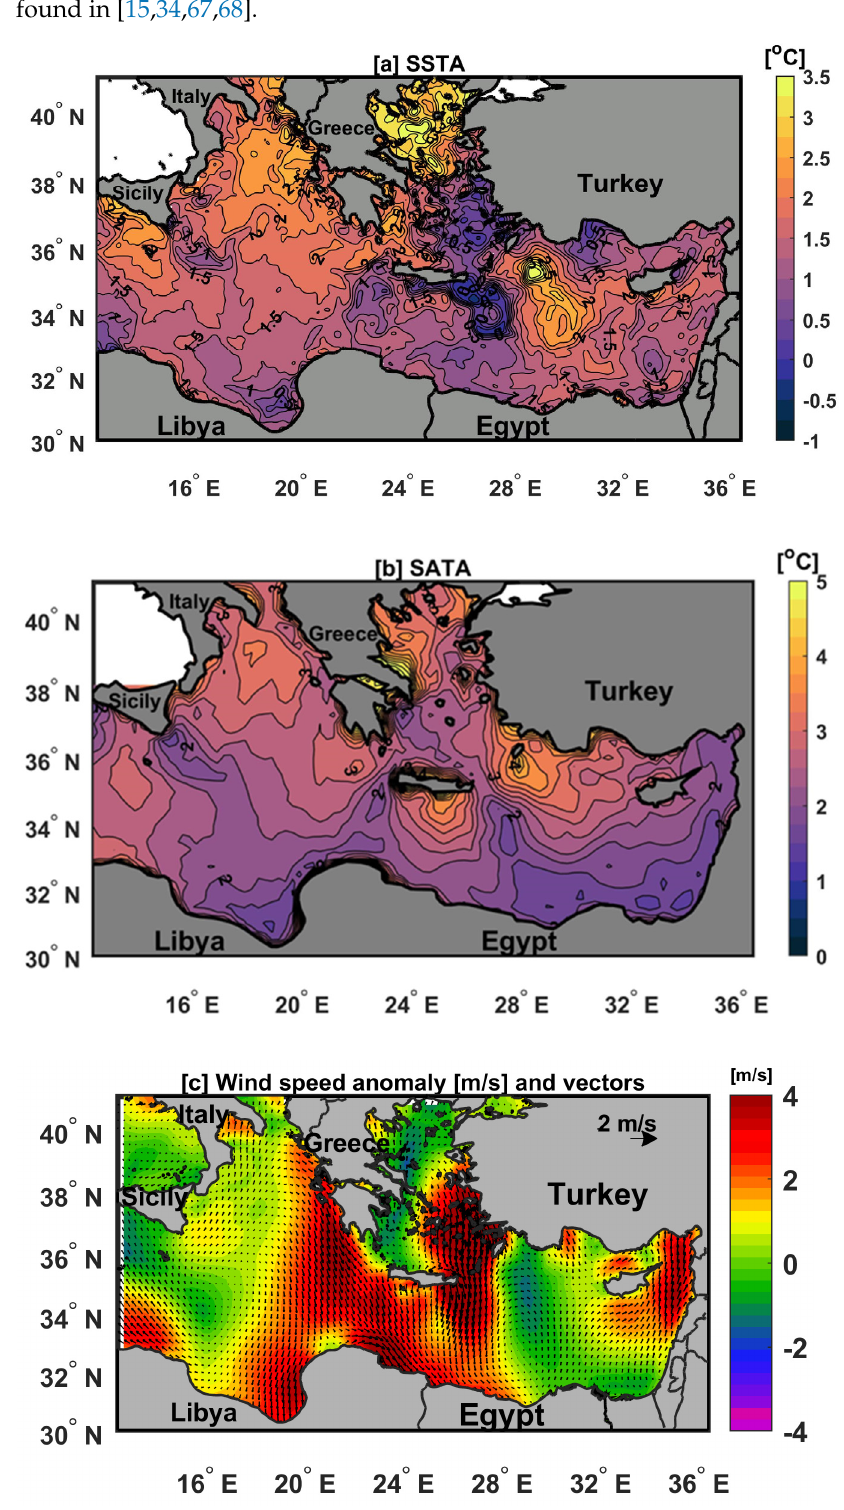
Figure 10. The spatial distribution of ( a ) SSTA (°C), ( b ) SATA (°C), and ( c ) wind speed anomaly (m/s) during the co-occurrence of MHW and AHW events from 29 July to 5 August 2021 over the EMED region.